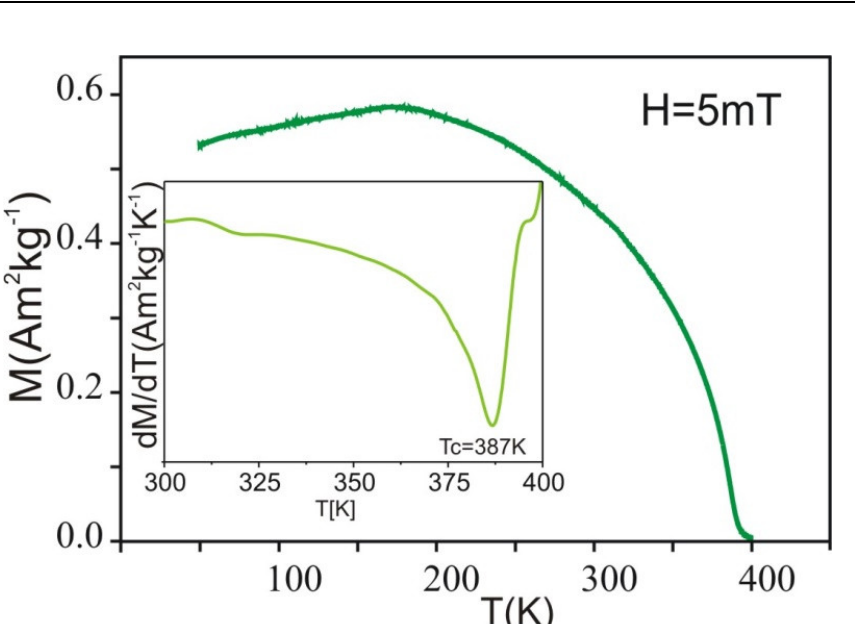
Figure 4. Specific magnetization, M measured at μ 0 H = 5 mT, as a function of temperature for the Fe 60 Co 12 Gd 4 Mo 3 B 21 alloy and the derivative dM/dT versus temperature (in insert). In order to determine the magnetic entropy change, the thermomagnetic curves M vs. H were collected for a wide range of temperatures. Taking into account the thermo- magnetic Maxwell relation [11]: